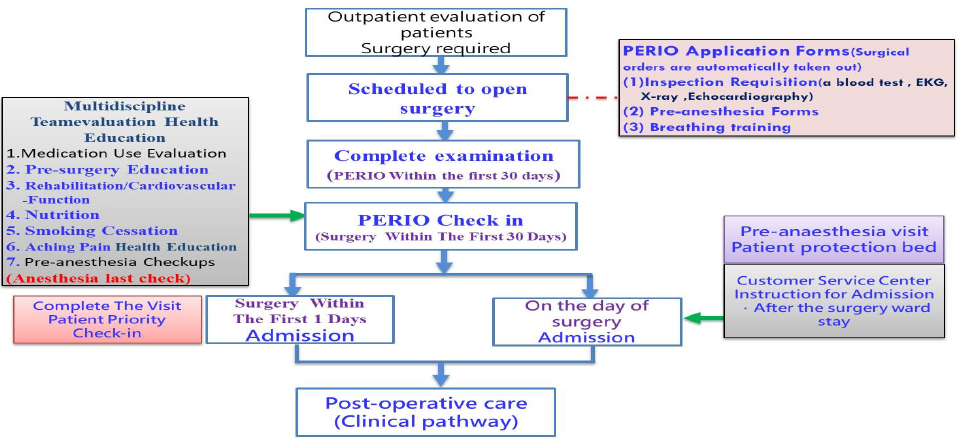
Figure 4. The present study established a perioperative assessment process.